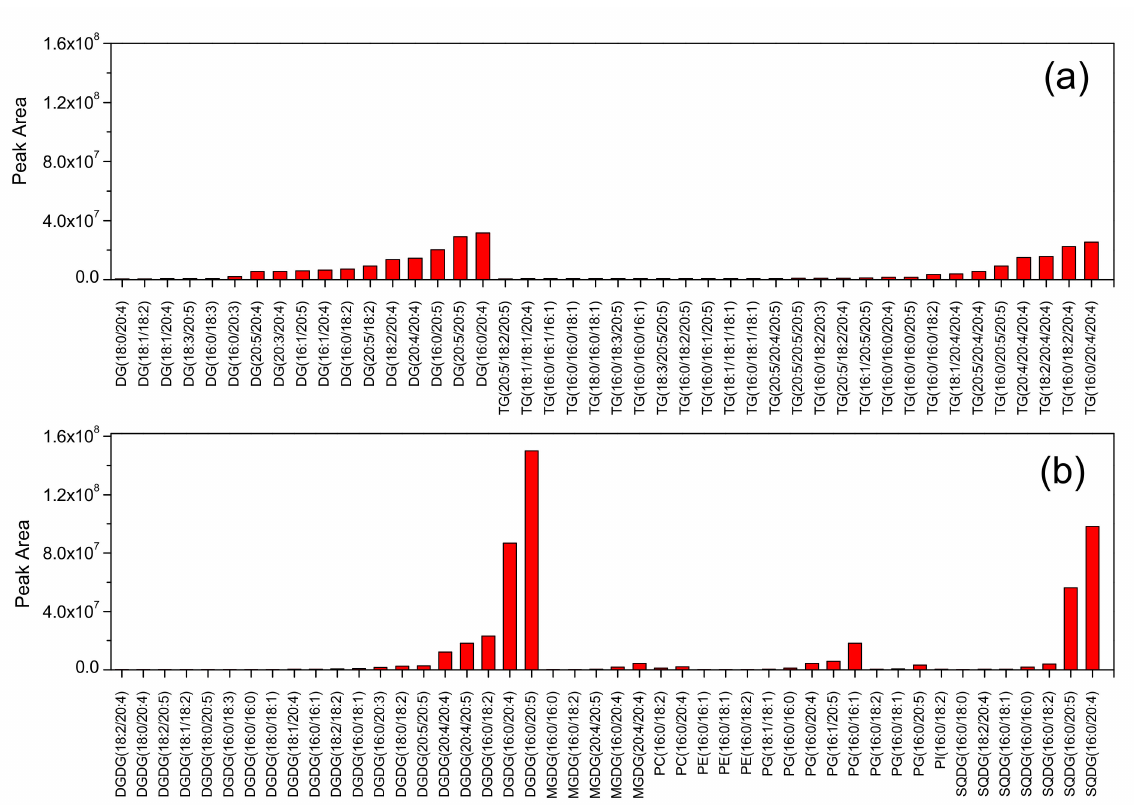
Figure 4. Lipomics analysis of crude lipid of Porphyridium purpureum . ( a ) neutral lipid and ( b ) polar lipid. digalactosyldiacyl- glycerol (DGDG), monogalactosyldiacylglycerol (MGDG), sulphoquinovosyldiacylglycerol (SQDG), phosphatidylglycerol (PG), diglyceride (DG), triglyceride (TG), and phosphatidylethanolamine